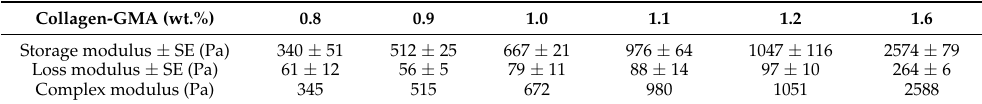
Table 1. Table of storage, loss and complex shear modulus values of collagen-GMA hydrogel at varying weight percent (wt.%). All values as at 0.1 rad s − 1 . n = 3. Collagen-GMA (wt.%) 0.8 0.9 1.0 1.1 1.2 1.6 Storage modulus ± SE (Pa) 340 ± 51 512 ± 25 667 ± 21 976 ± 64 1047 ± 116 2574 ± 79 Loss modulus ± SE (Pa) 61 ± 12 56 ± 5 79 ± 11 88 ± 14 97 ± 10 264 ± 6 Complex modulus (Pa) 345 515 672 980 2588